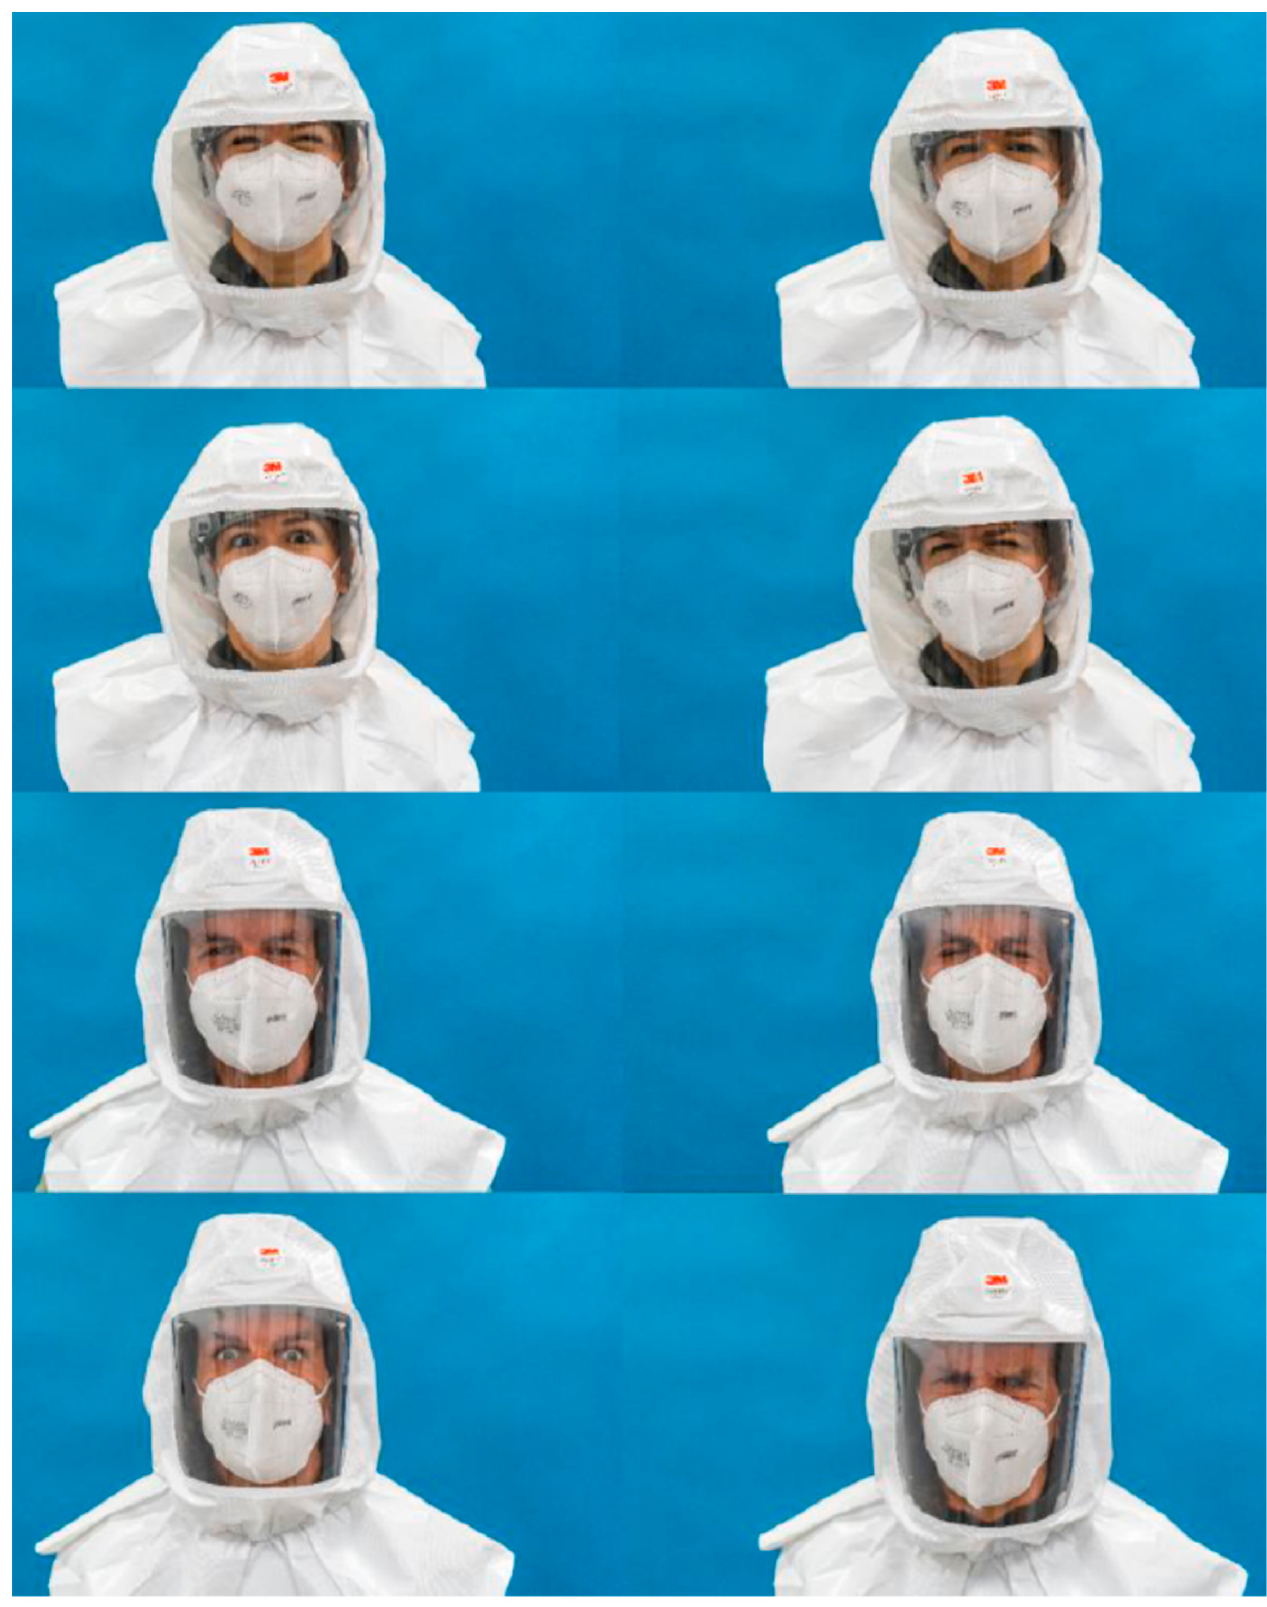
Figure 4. Photographs of the four emotions by an actress and an actor wearing a powered air-purifying respirator-PAPR and an FFP2 mask (from left to right: happy; sad; fear/surprise; and disgust/anger).